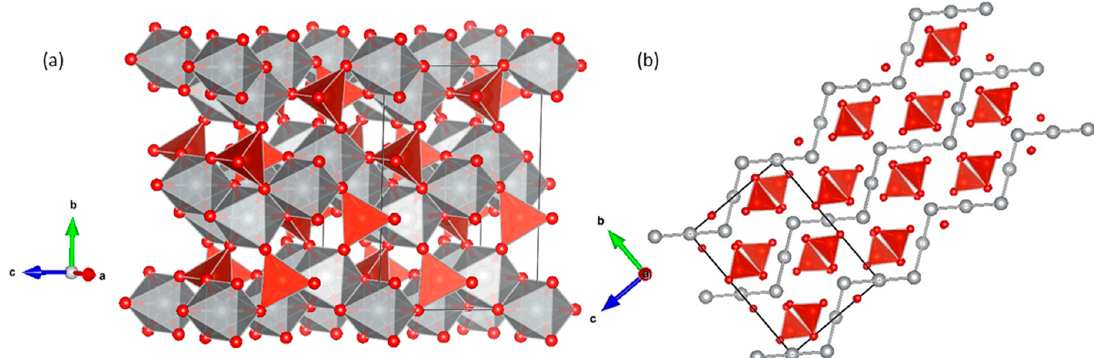
Figure 1. ( a ) Crystal structure of Ni 3 V 2 O 8 . NiO 6 octahedra are shown in grey and VO 4 tetrahedra are in red. Small red circles are oxygen atoms. ( b ) Projection of the crystal structure showing VO 4 tetrahedra (in red) and Ni atoms (in gray) connected to make more evident the kagome staircase framework. Three unit cells are included in ( b ). The unit cell is shown is black solid lines.